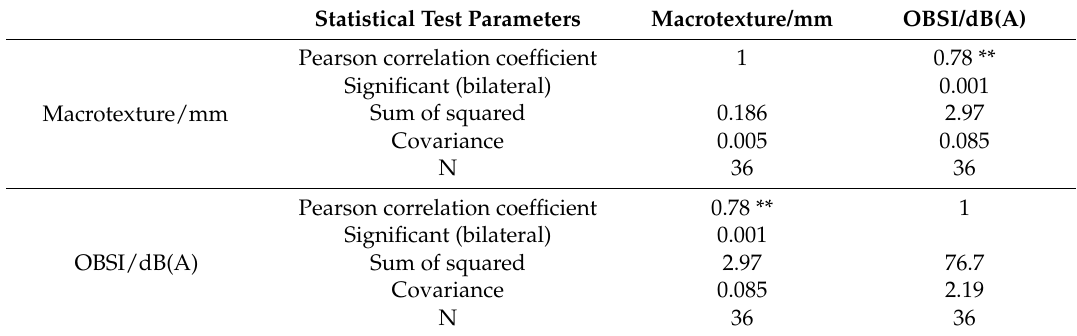
Table 7. Correlation analysis between macrotexture and noise of longitudinal groove pavement.